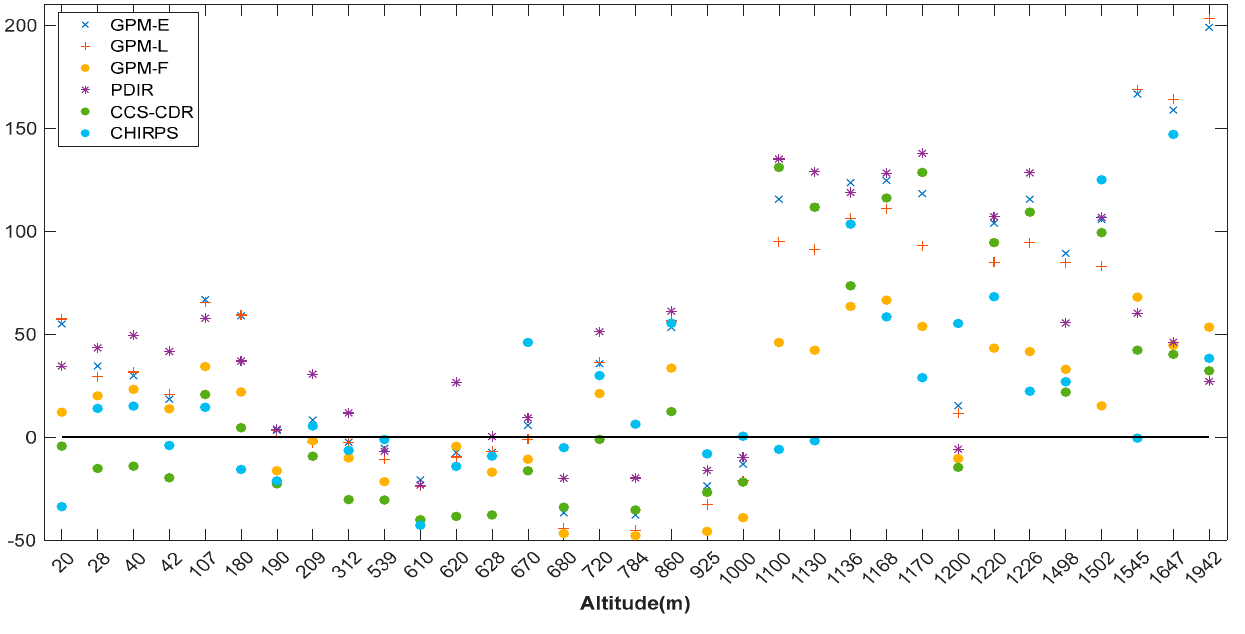
Figure 4. The relative bias of the satellite estimates according to the rain-gauge altitudes.